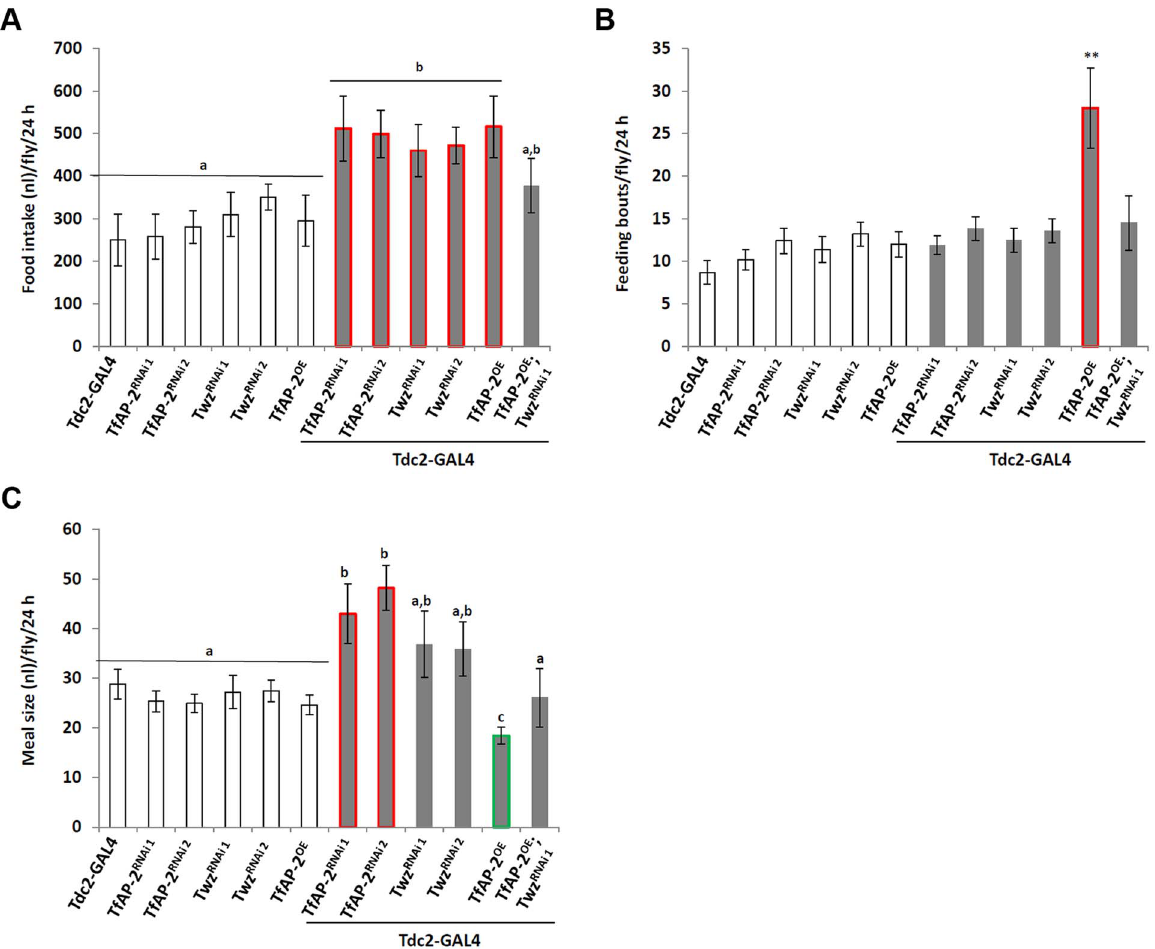
Figure 3. TfAP-2 and Twz regulate normal feeding behavior. (A–C) A CAFE assay was used to assess total food intake (A), the average number of feeding bouts (B) and meal size (C) over a 24 h period in 5–7 days old adult males. Five males were used for each replicate and the assay was repeated at least 10 times for each genotype. In A and C, different letters indicate similar groups (i.e. ‘a’ is significantly different than ‘b’ or ‘c’ and so on. A non-parametric Kruskal-Wallis ANOVA was performed with Dunn’s post hoc test for multiple comparisons, P , 0.05), in B a double asterisk indicates significant difference (A non-parametric Kruskal-Wallis ANOVA was performed with Dunn’s post hoc test for multiple comparisons, P , 0.005) compared with all other strains. Error bars represent the SE (SEM).